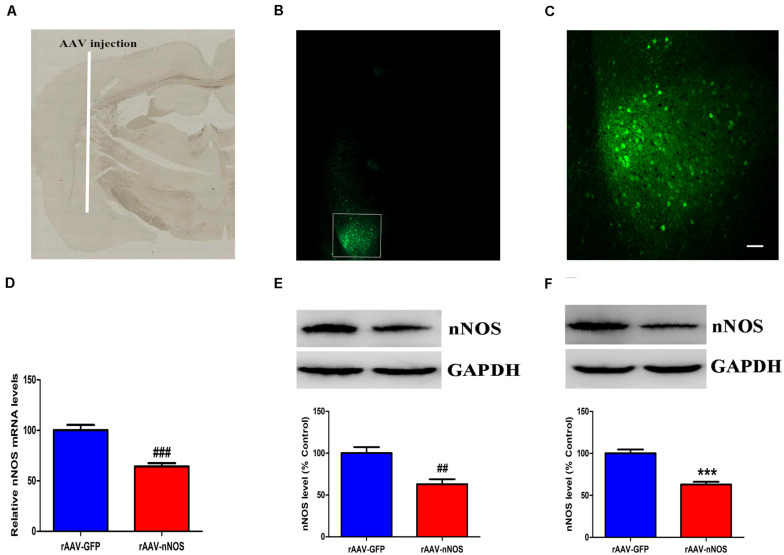
Distribution of green fluorescent protein (GFP) and the impact of rAAV-nNOS on endogenous nNOS expression in mice. (A) BLA injection site at low magnification. (B) GFP signals observed in BLA interneurons at 7 days post-injection confirmed successful nNOS vector expression. (C) Higher-magnification view of boxed BLA area in (B). Scale bar, 60 μm. Mice with rAAV-nNOS injection showed significantly lower expression of nNOS mRNA (D) and protein (E) compared with the control group. (F) Three weeks after the injection of rAAV vectors, the expression of nNOS protein in the rAAV-nNOS group was significantly lower than controls. ###p < 0.01, ##p < 0.01, ***p < 0.001, compared with rAAV-GFP-treated group. n = 5. Student’s t-tests were performed. All data are presented as means ± SEM.